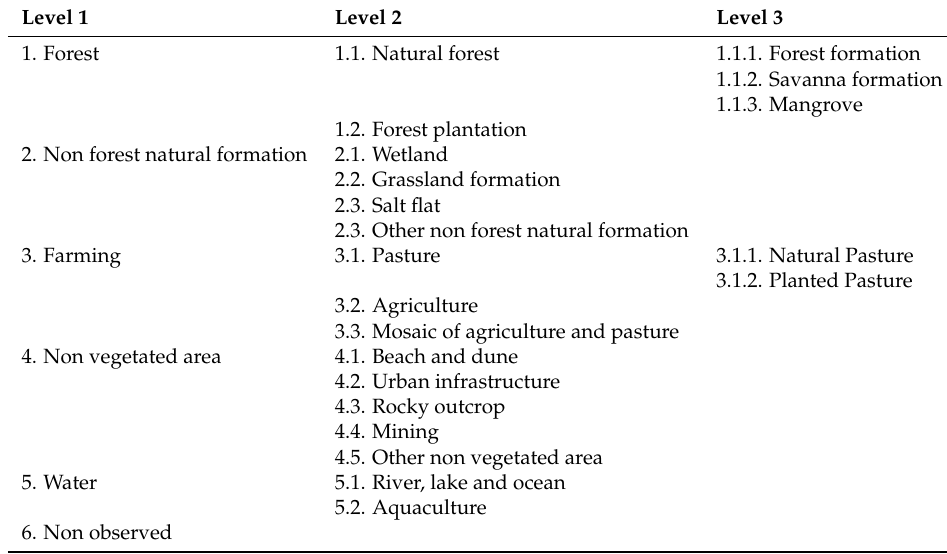
Table 1. Classification scheme of MapBiomas cartography (collection